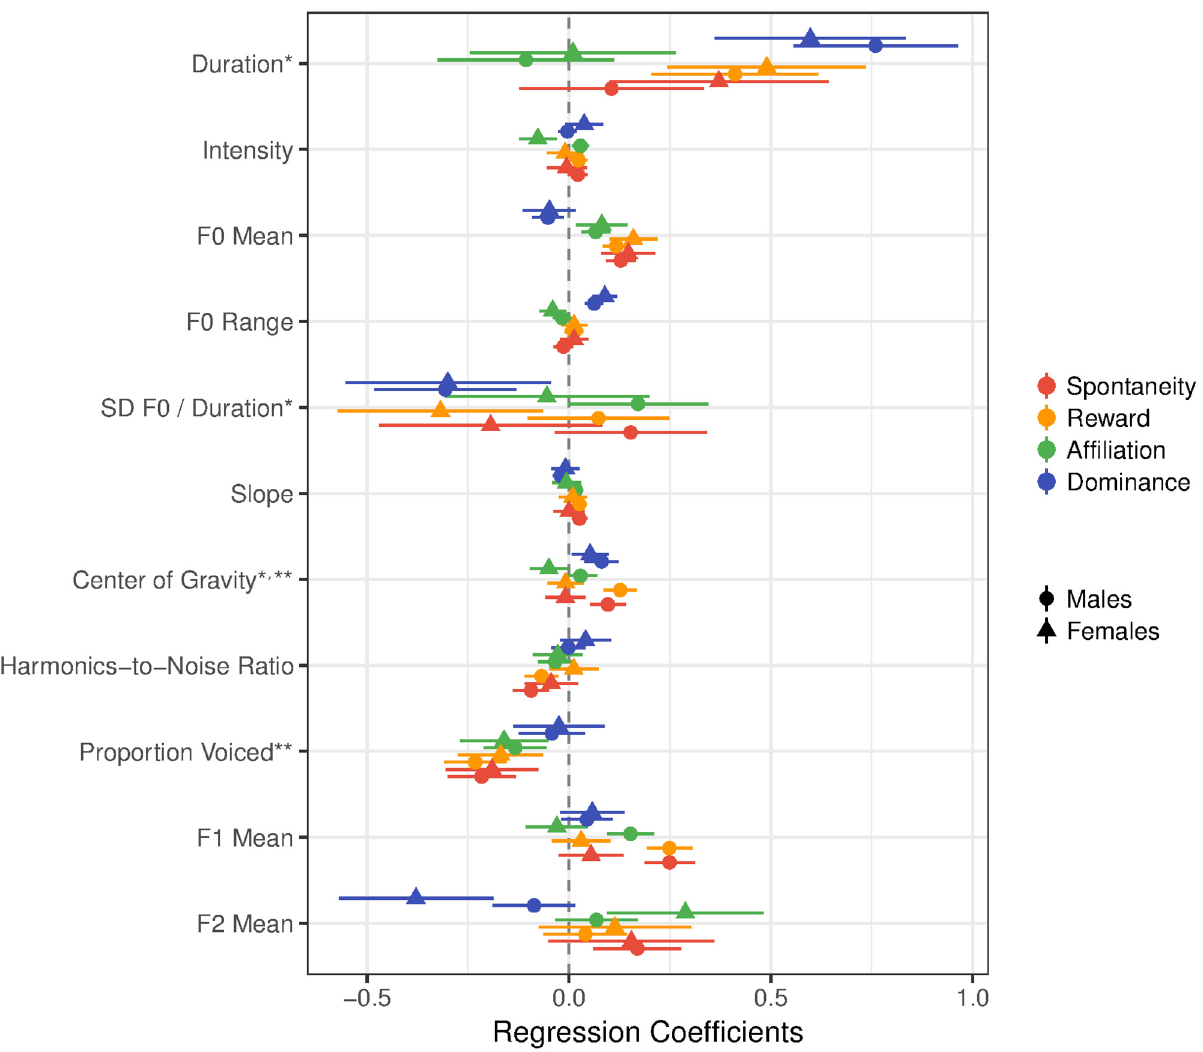
Fig 2. Unstandardized regression coefficients and 95% confidence intervals for models predicting spontaneity, reward, affiliation, and dominance ratings for male and female actors. Footnotes . Estimates from models in which the sex variablewas centeredover males (circles) and when it was centered over females(triangles),illustratingthe effects of the acoustic variableson social judgments separatelyfor male and female actors. Since unstandardized regressioncoefficients are reported, comparisons are best made within each variablerather than across variables, as the scales are different. * Indicatescoefficient and standarderror for a log-transformed predictor. ** Indicates the coefficient and standarderror were dividedby 10 to better match the size of the other coefficients.